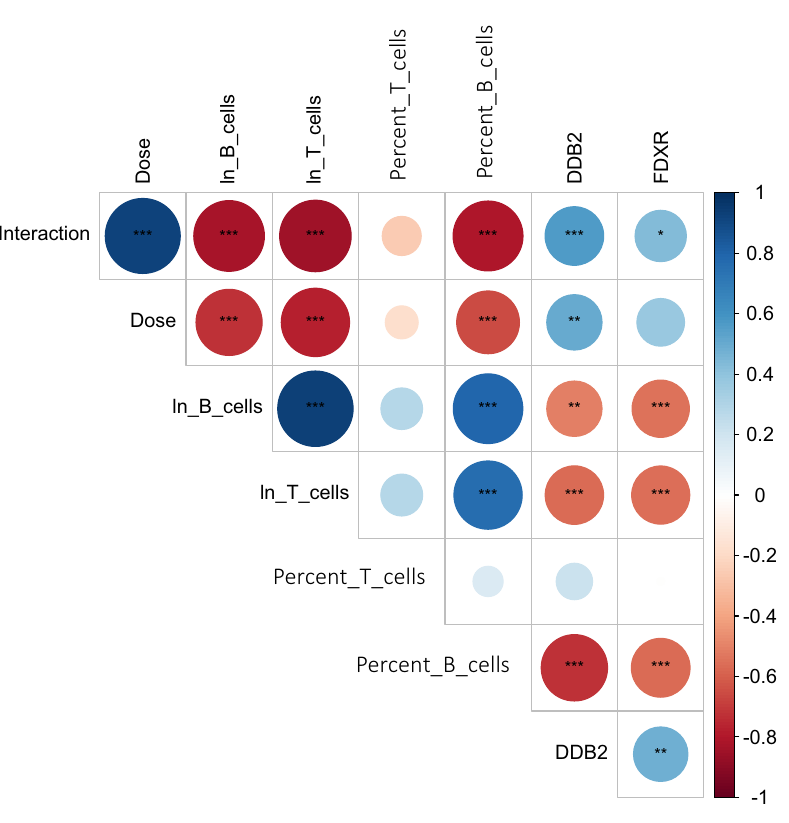
Figure 5. Matrix of Spearman’s correlation coefficients between all variables in the training data. Interaction = Dose for TBI, and Interaction = Dose/2 for PBI. Blue circles represent positive correlations, and red circles represent negative ones. Larger circles represent stronger correlations. Asterisk symbols represent Bonferroni-corrected p -values: * < 0.05, ** < 0.01, *** <